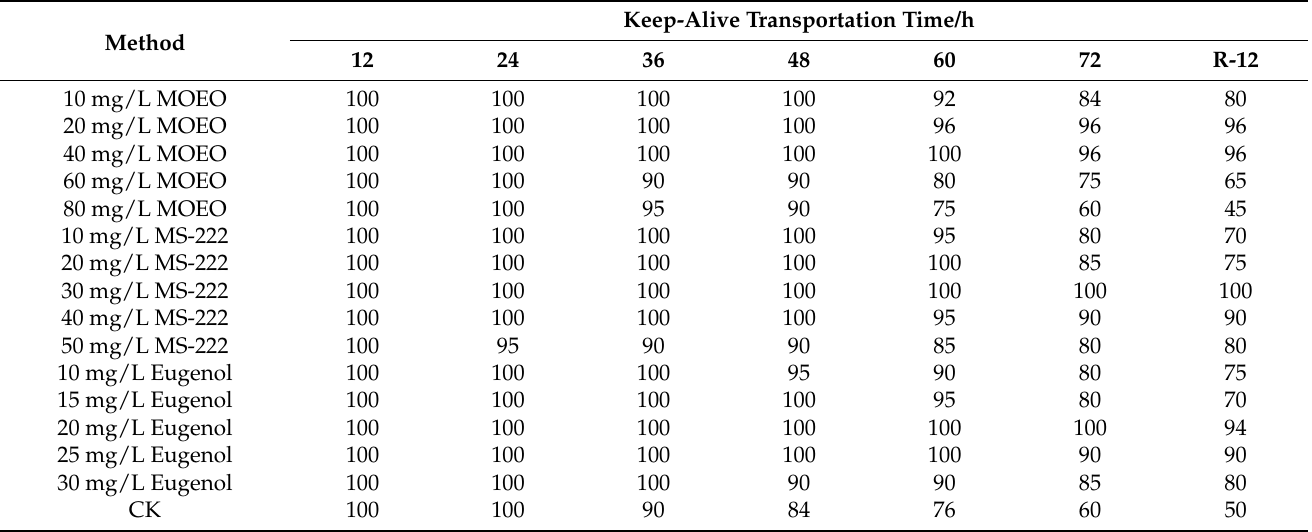
Table 1. Determination of survival rates (%) in different treatment groups during live sea bass transport and after 12 h of recovery